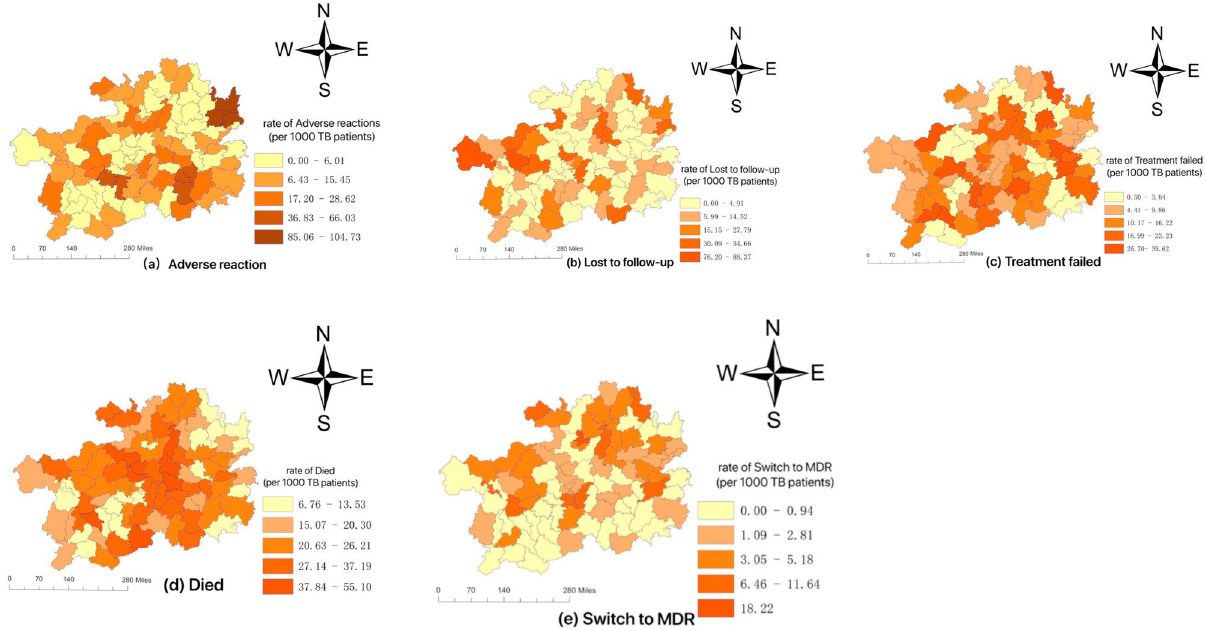
Figure 3. The spatial distribution of adverse outcomes of TB in Guizhou during 2013–2018. ( a ) Geographic distribution of rate of adverse reaction; ( b ) Geographic distribution of rate of lost to follow-up; ( c ) Geographic distribution of rate of treatment failed; ( d ) Geographic distribution of rate of died; ( e ) Geographic distribution of rate of switch to MDR.